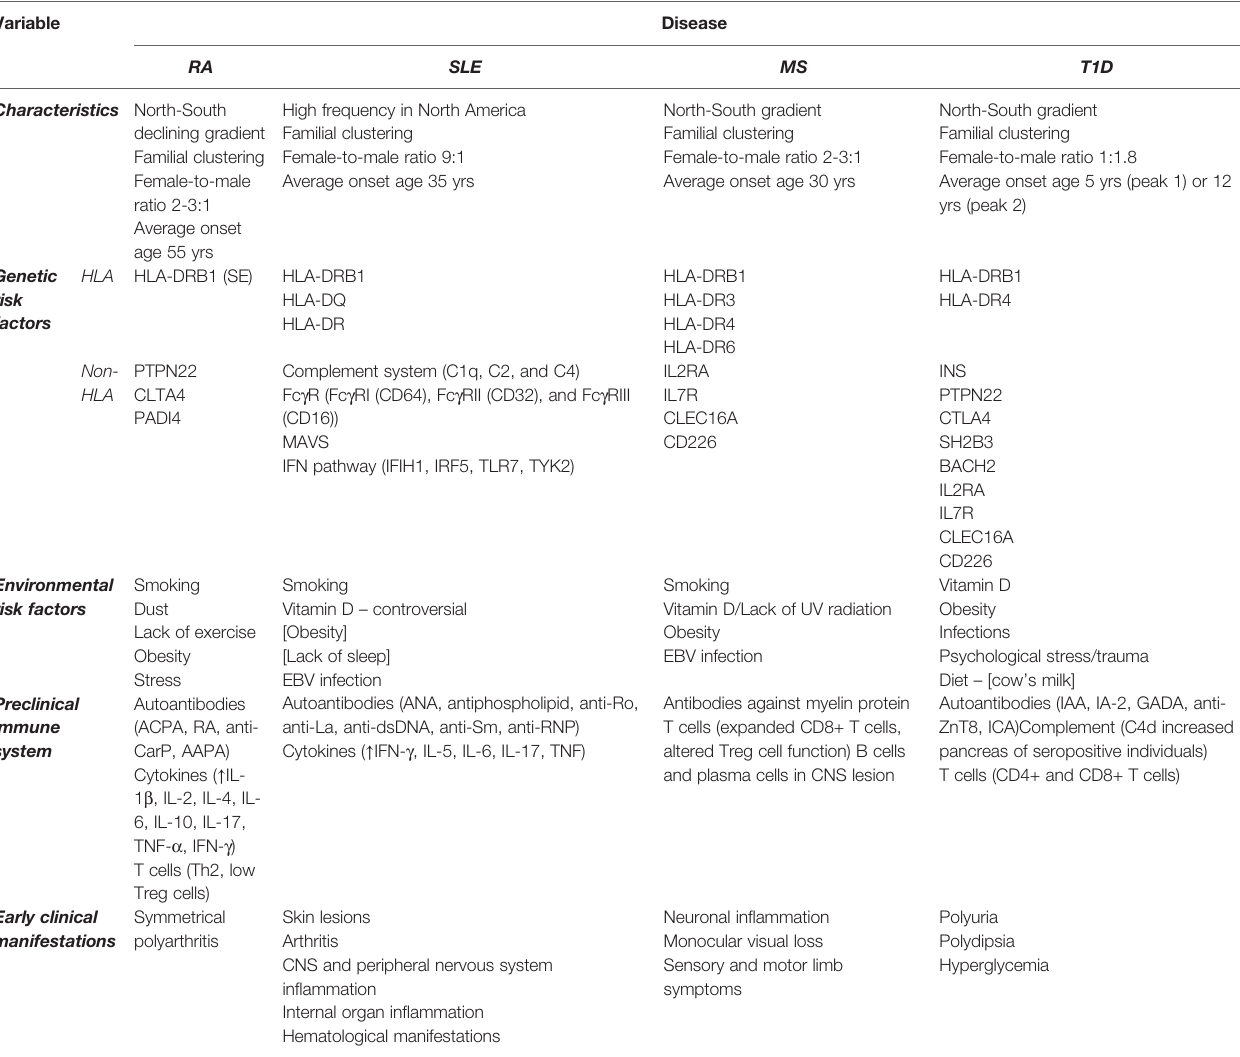
TABLE 1 | Overview of selected major characteristics, risk factors, immunological and clinical features of four autoimmune diseases.